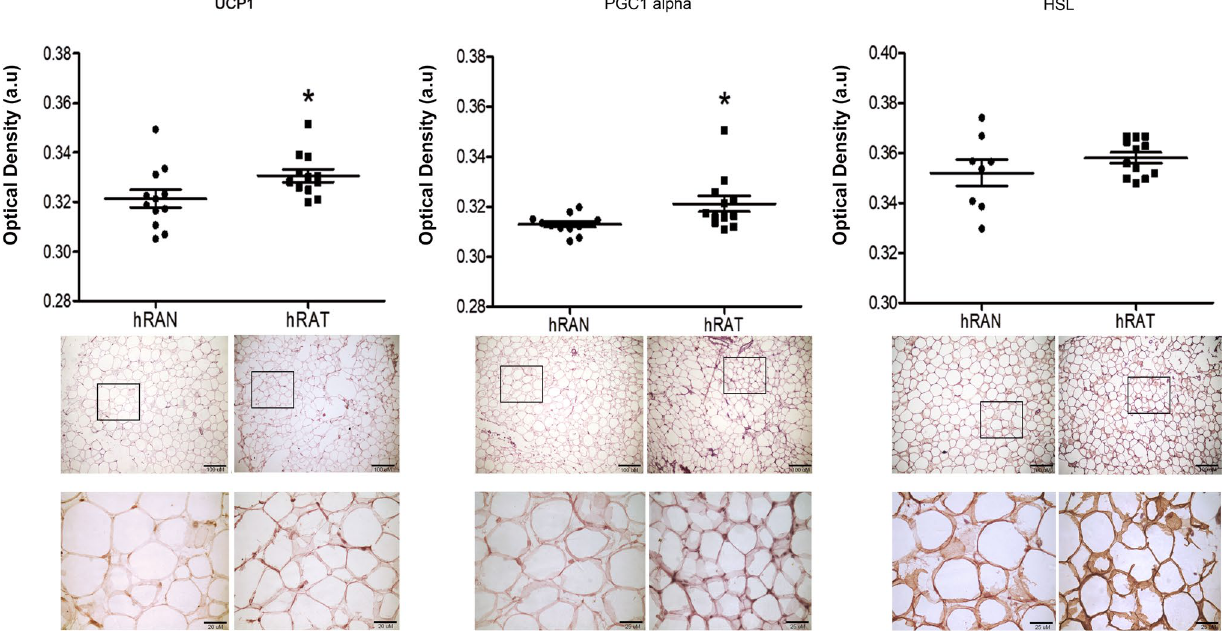
Figure 3. UCP1, PGC1 alpha and HSL expression in histological sections of hRAN and hRAT. UCP1, PGC1 alpha and HSL expression was evaluated by immunohistochemistry in serial cuts of hRAN and hRAT. DAB staining quantification in the three tissue types was performed with Image J software (NIH). Histograms show mean ± SEM of five independent experiments. (a.u.: arbitrary units). * p < 0.01 hRAN versus hRAT. Representative photographs of hRAN- and hRAT-staining. Magnification: 10× and 40×. Arbitrary units (a.u) represent pixel quantification.